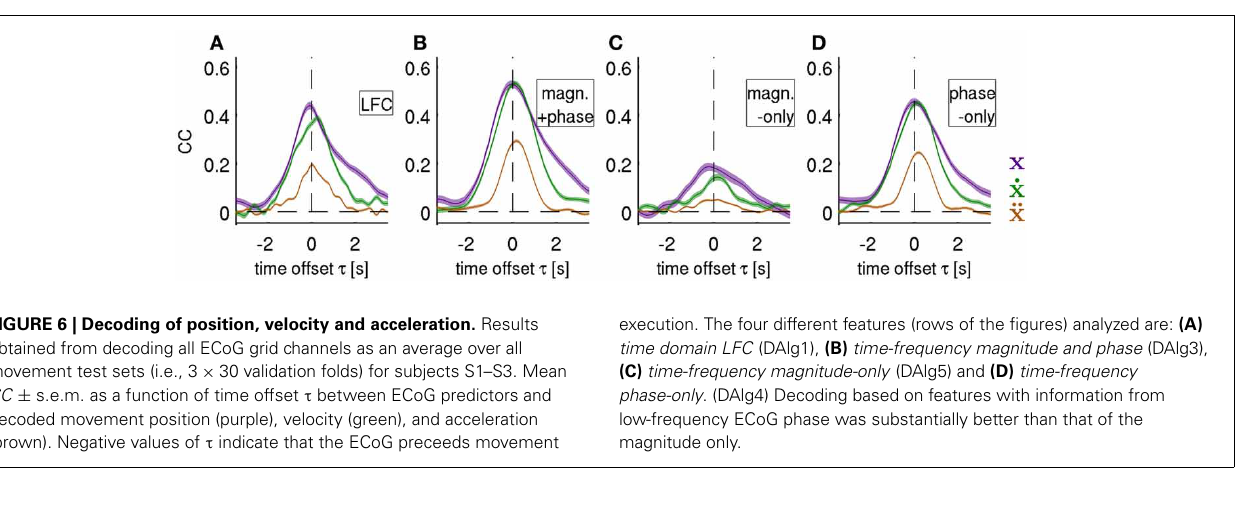
execution. The four different features (rows of the figures) analyzed are: (A) time domain LFC (DAlg1), (B) time-frequency magnitude and phase (DAlg3), (C) time-frequency magnitude-only (DAlg5) and (D) time-frequency phase-only . (DAlg4) Decoding based on features with information from low-frequency ECoG phase was substantially better than that of the magnitude